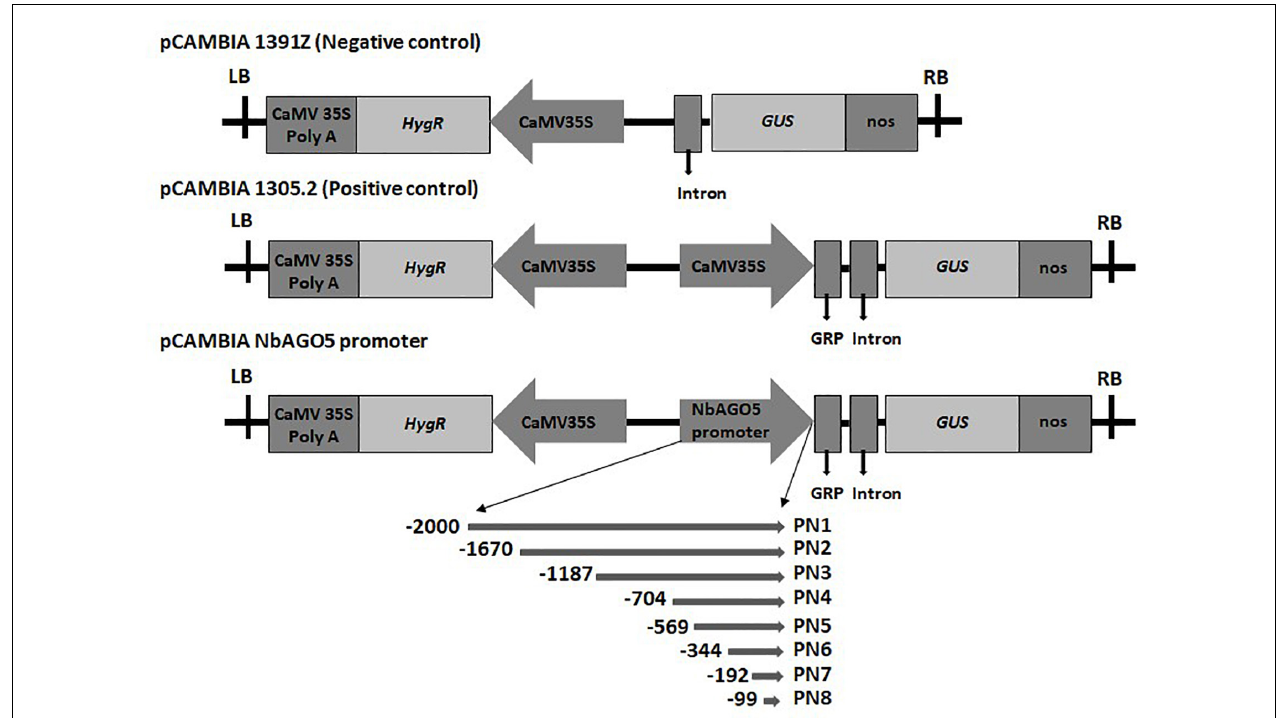
FIGURE 1 | Schematic diagrams of the truncated fragments of different deleted versions fused with the GUS reporter gene. The pCAMBIA1391Z vector acts as a negative control that does not have a promoter to drive GUS. The pCAMBIA1301 vector was used as a positive control, and the pCAMBIA NbAGO5 promoter constructs with different lengths of NbAGO5 promoter was created by replacing the 35S promoter (A). LB, left border; CaMV 35S PolyA, cauliflower mosaic virus 35S terminator; HygR , hygromycin resistance gene; 35S promoter, cauliflower mosaic virus 35S promoter; GRP , glycine-rich signal peptide sequence; GUS, β -glucuronidase reporter gene; Nos, nopaline synthase terminator; RB, right